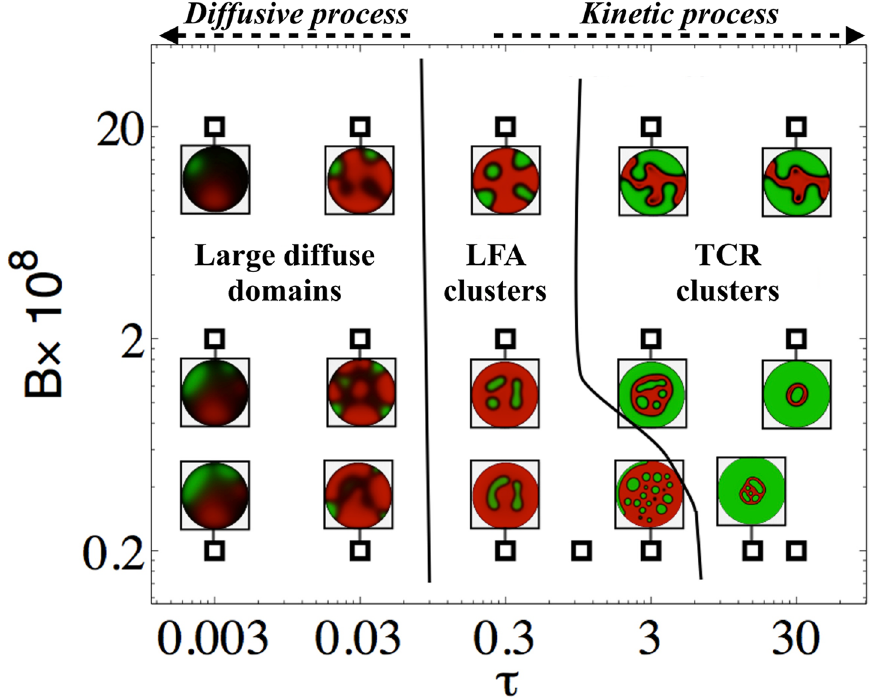
Fig 4. Phase space that characterizes the different regimes of membrane protein patterns as a function of B ¼ patterning is measured at t = 40 min where a synaptic pattern is typically formed in experiments [2, 3, 20, 21], i.e. in dimensionless units ( L / l 2 ) 2 t = 16. Two different protein patterns are identi fi ed; large diffuse patches and dispersed kinetic clusters, which are categorized into three regimes. In the diffusional dominated limit ( τ < 0.3) large diffusive patches are predicted that translocate on the membrane. A transition to a dispersed protein pattern is observed for τ > 0.3. In the intermediate regime (0.3 (cid:11) τ (cid:11) 3), long-lived LFA clusters form on the membrane. When the protein dynamics is an active process ( τ > 3) micro-scale TCR clusters nucleate and coalesce as they are transported radially forming a central dense pattern. In the kinetic regime we see that the cluster size varies as a function of B , similar to our scaling prediction (cid:3) B 1 4 . At equilibrium, all simulations predict a fl at membrane with a single protein phase for the case where fl uid fl ux at the edge of the IS is free and the membrane height and number of proteins per membrane area is fi